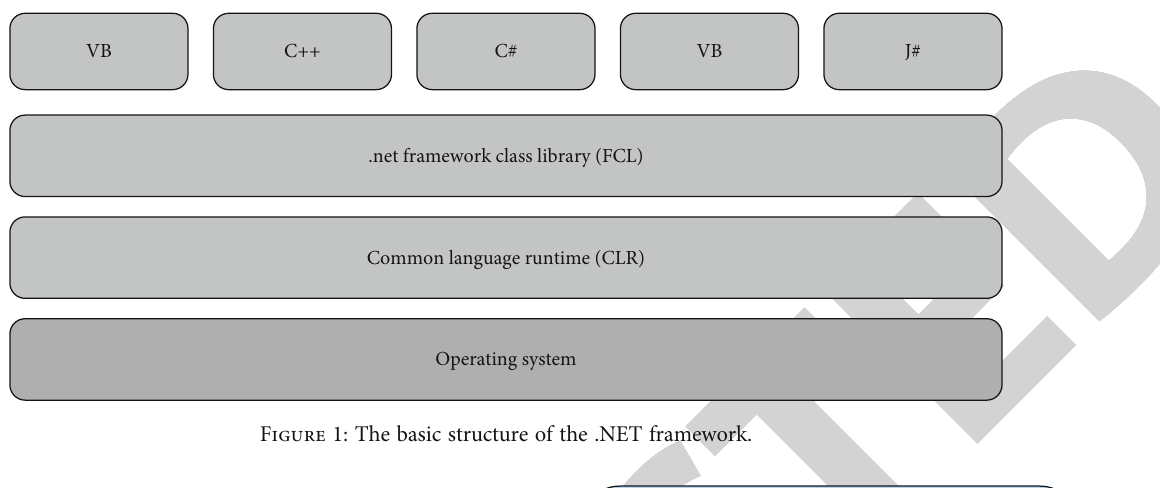
Figure 1: The basic structure of the .NET framework.